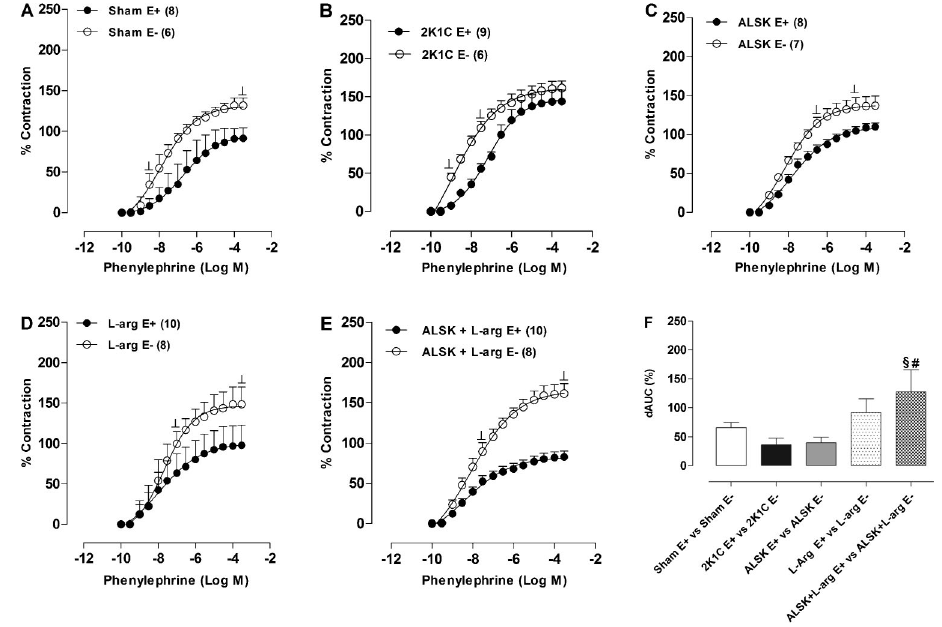
Figure 2. Effects of endothelium removal (E––) on the concentration-response curve for phenylephrine in the aortic rings from Sham ( A ), 2K1C ( B ), aliskiren (ALSK) ( C ), L-arginine (L-arg) ( D ) and ALSK++L-arg ( E ) treatment in the aortic rings with (E++) and without (E––) endothelium. The differences in the area under the concentration-response curves (dAUC) in endothelium-denuded and intact segments is shown in F . Data are reported as means±SE. The number of animals in each group is indicated in parentheses. # P , 0.05 vs ALSK; 1 P , 0.05 vs 2K1C and H P , 0.05 vs E++ (two-way ANOVA, followed by Tukey’s post hoc